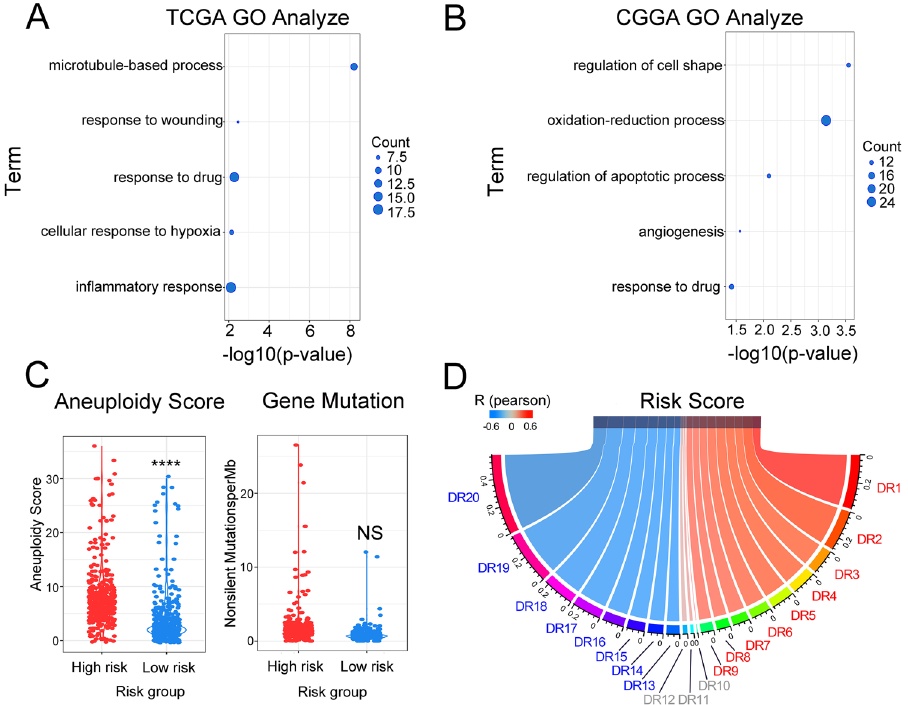
Figure 4. The functions analyses of the signature. ( A , B ) GO function enrichment analysis in the TCGA and CGGA databases. ( C ) Correlation between the risk group and aneuploidy score or gene mutation in the TCGA database. ( D ) Correlation between the risk score and DNA repair functions in the TCGA database. (DR1: Homologous recombination; DR2: Repair of DNA-topoisomerase crosslinks; DR3: Fanconi anemia/ tolerance and repair of DNA crosslinks and other adducts in DNA; DR4: Editing and processing nucleases; DR5: Modulation of nucleotide pools; DR6: Base excision repair (BER)/DNA glycosylases: major altered base released; DR7: Chromatin structure and modification; DR8: Other BER and strand break joining factors/Other BER and strand break joining factors; DR9: Nucleotide excision repair (NER)/(XP = xeroderma pigmentosum); DR10: Direct reversal of damage; DR11: Ubiquitination and modification; DR12: Mismatch excision repair (MMR); DR13: Other identified genes with known or suspected DNA repair function; DR14: Genes defective in diseases associated with sensitivity to DNA damaging agents; DR15: Other conserved DNA damage response genes; DR16: TFIIH/Catalyzes unwinding in pre-incision complex; DR17: Non-homologous end-joining; DR18: DNA polymerases (catalytic subunits); DR19: Poly(ADP-ribose) polymerase (PARP) enzymes that bind to DNA; DR20: